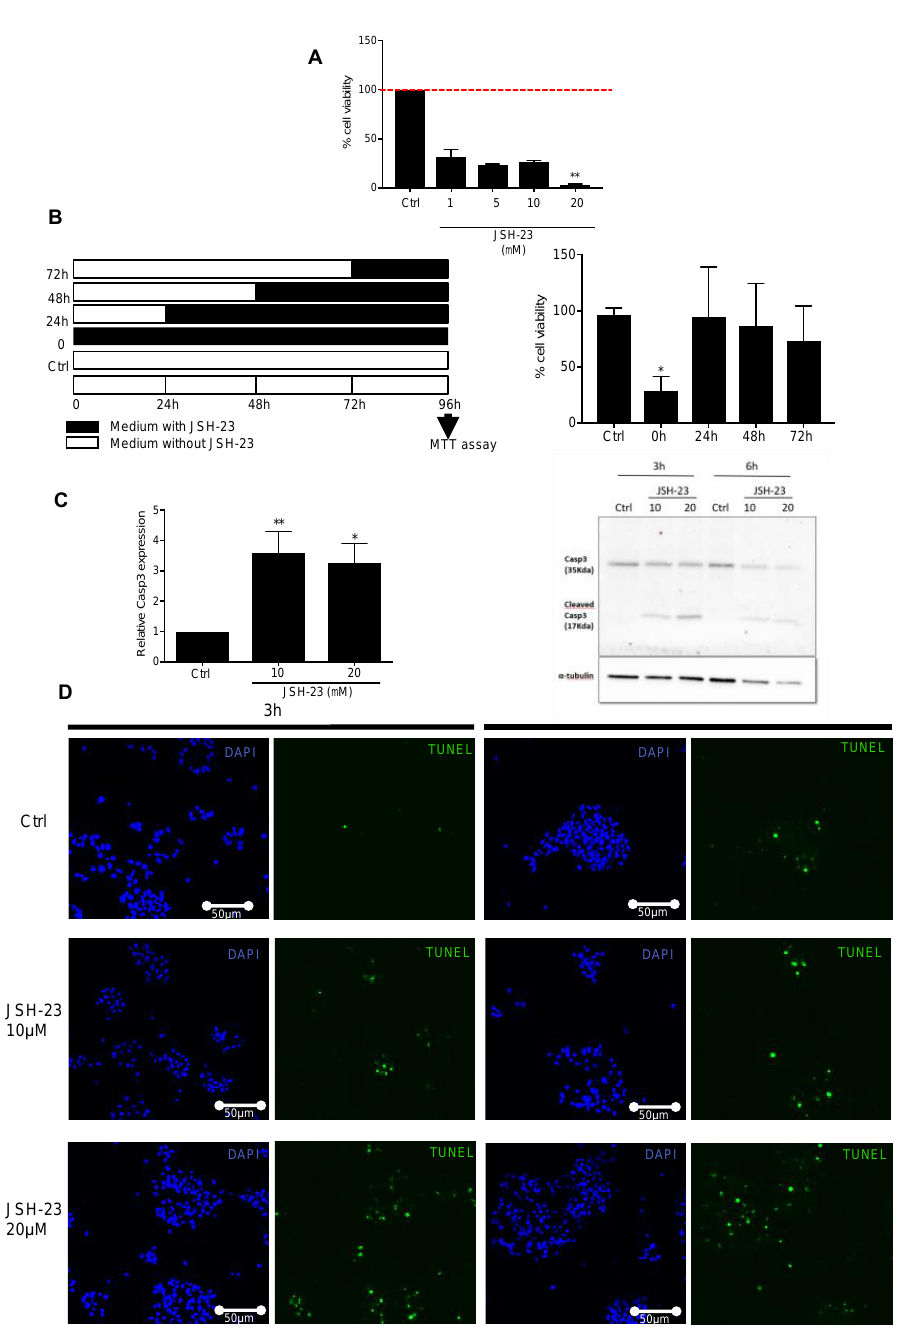
Figure 1. Inhibition of the NF-kB pathway by JSH-23 obstructs the astrocytic differentiation via Caspase 3 cleavage. ( A ) JSH-23 (1, 5, 10, 20 mM) induces the loss of cell viability by MTT assay after a 48 h treatment ( n = 3, mean ± SEM). ( B ) JSH-23 decreases the cell viability during the first step of astrocyte differentiation. JSH-23 (10 mM) was added at different time points during astrocytic differentiation (0, 24, 48, 72 h) and the MTT assay was performed after 96 h ( n = 3, mean ± SEM). * p < 0.05 ( C ) Analysis of the expression levels of Caspase3 after treatment with JSH-23 at different concentrations by RT-PCR (6 h) (C, n = 5, mean ± SEM) and by Western blot (3 and 6 h) (D, n = 3). α -tubulin was used as a loading control. * p < 0.05 and ** p < 0.01 ( D ) TUNEL assay was performed to explore cell death induced by JSH-23 (10, 20 mM) at 3 and 6 h. Nuclei were stained with DAPI (blue) and TUNEL positive cells display green nuclei. Scale bar: 50 µm.